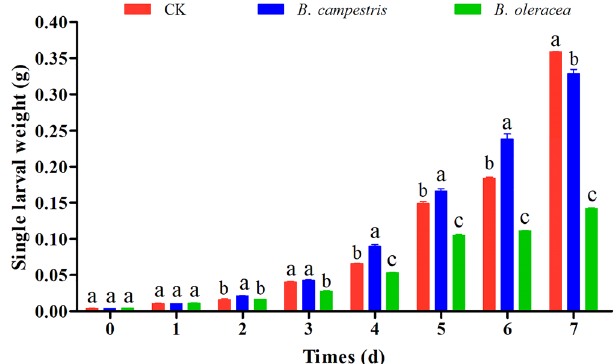
Figure 1. The effects of B. campestris and B. oleracea on the growth of S. frugiperda . The values of single larval weight for every day were shown as mean ± SEM (n = 20). Larvae fed on an artificial diet were used as a control. (version 9.0) (https:// www. graph pad. com/ scien tific- softw are/